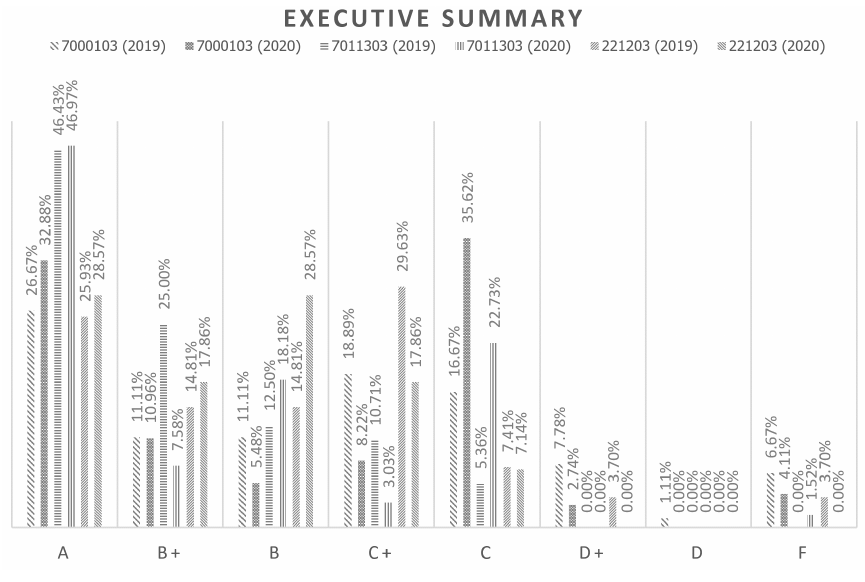
Comparison of academic